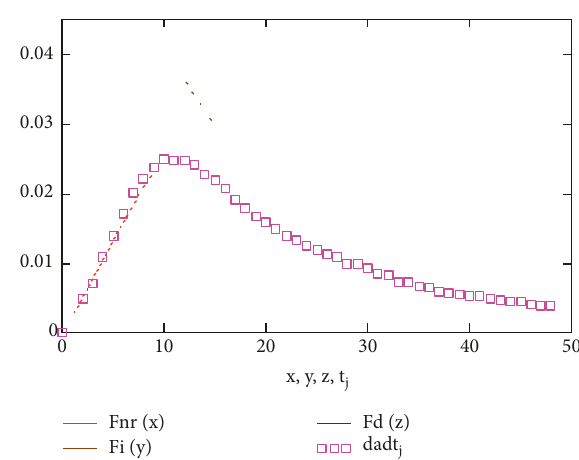
Figure 5: Hydration rate curves of sample